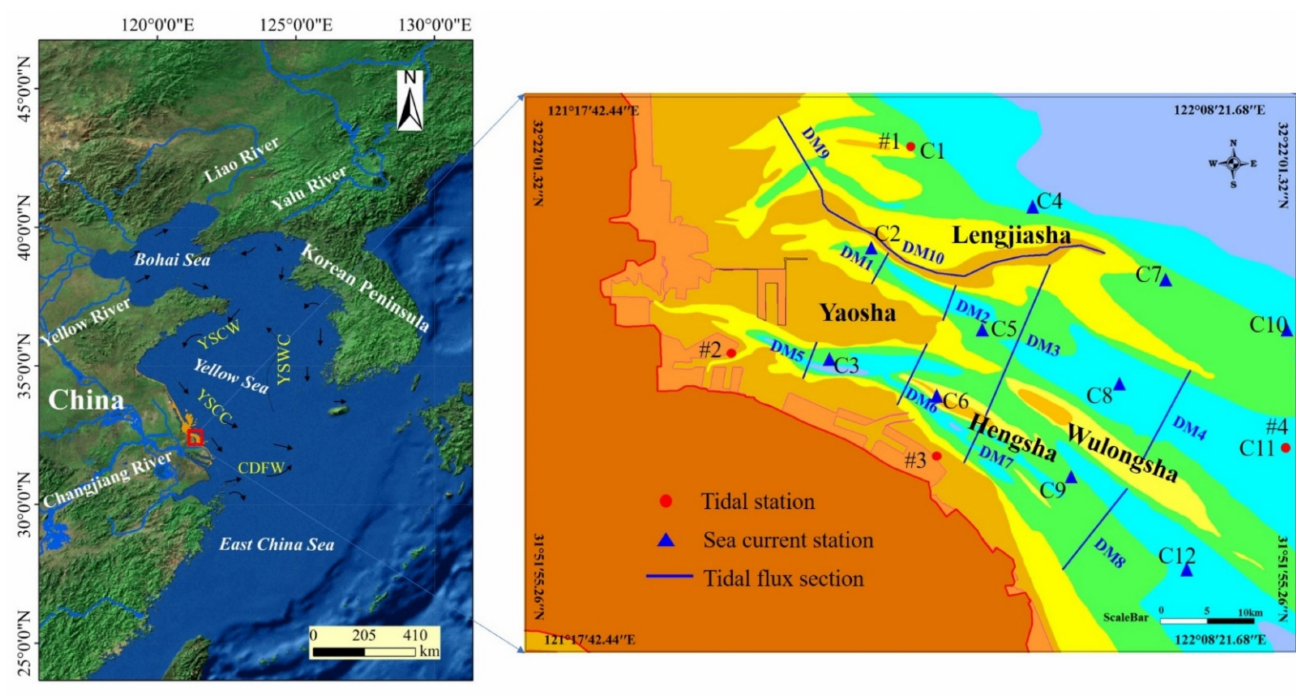
Figure 1. The map of study